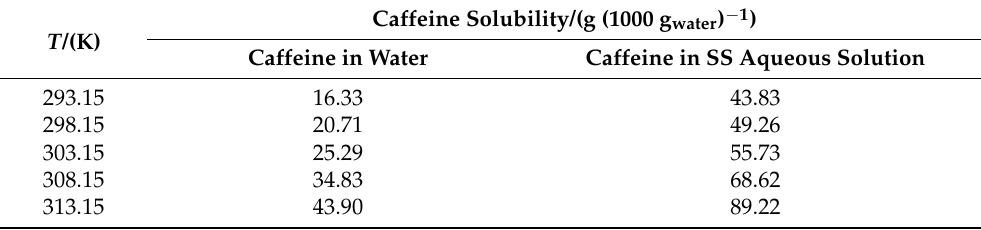
Table 1. Determined solubility of caffeine in water and caffeine in 0.1 mol · kg − 1 SS aqueous solutions in the temperature range from T = 291.15 to 313.15